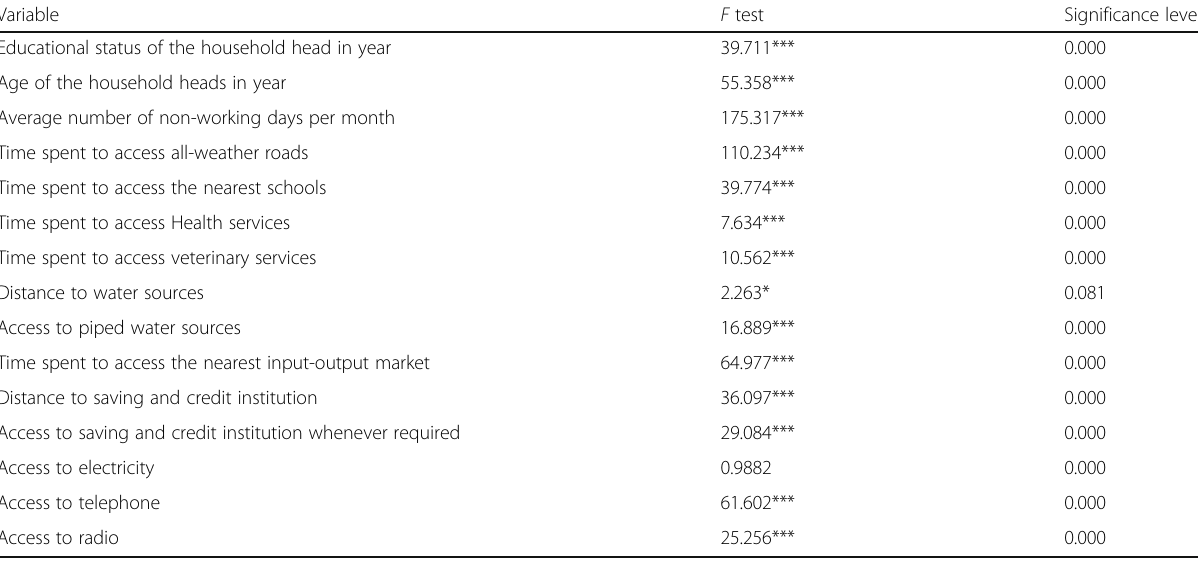
Table 4 Explanatory variables considered for ANOVA for the four agro-ecological systems